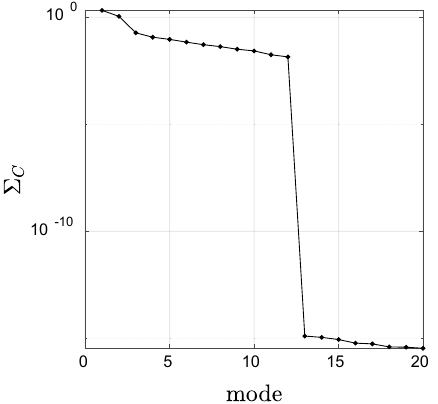
Figure 8. Canonical correlation between the time series of CO 2 and